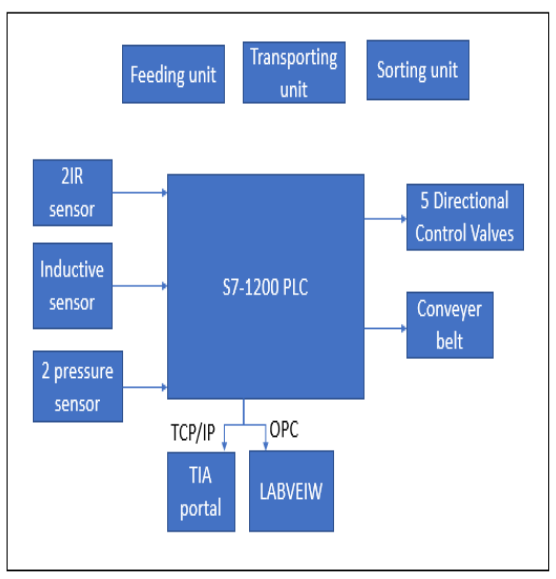
Fig. 9. The system block diagram.